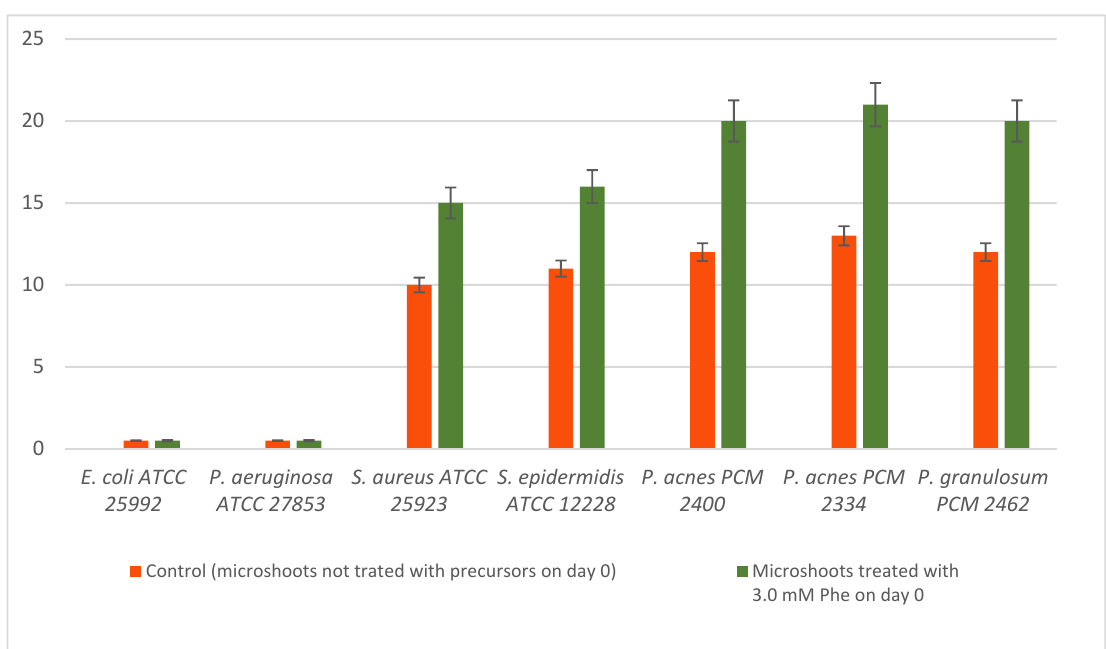
Figure 3. Zones of bacterial growth inhibition by the tested N. officinale extracts (mm).